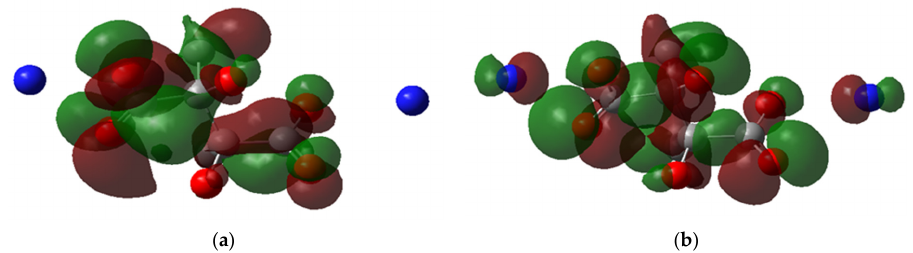
Figure 8. The molecular orbital maps, ( a ) LUMO and ( b ) HOMO, of the PESA- CH 3 -NH 4 -1n molecule.